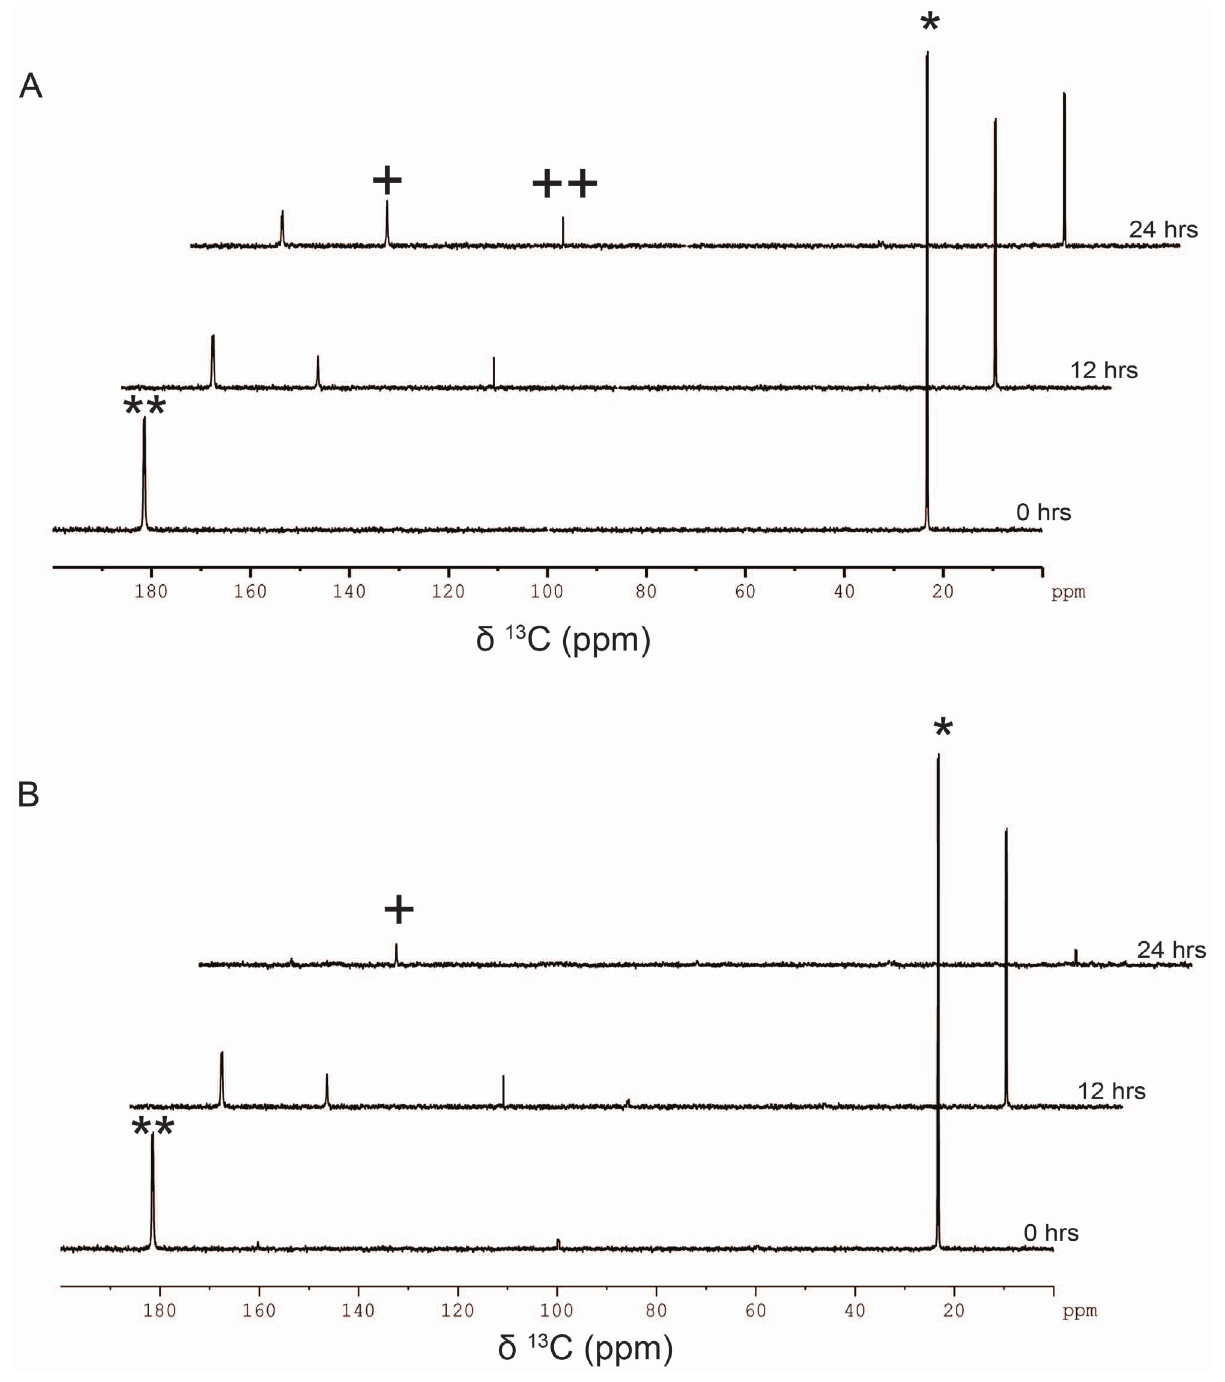
Figure 4. Assimilation kinetics of [1, 2- 13 C]-acetate during heterotrophy and mixotrophy in the presence of photosynthesis inhibitor atrazine. Assimilation kinetics of acetate and metabolite formation by C. reinhardtii during (A) heterotrophy and (B) mixotrophy following the addition of [1, 2- 13 C]-acetate to the TP medium containing atrazine (5 m M). Atrazine stock (10 mM) was prepared in water from where 5 m M atrazine was achieved. (The signs * and ** represent methyl and carboxyl peaks, respectively, of [1, 2- 13 C]-acetic acid, and the signs + and ++ represent bicarbonate and CO 2aq peaks, respectively). doi:10.1371/journal.pone.0106457.g004 (Fig. 1C and 3C). Early production of starch and lipid during starch and lipid accumulation, it takes much longer time. Several photoautotrophy was suggestive of a more efficient flux of carbon days of nutritional stress precedes starch and lipid formation towards the starch and lipid biogenesis via Calvin cycle route. during mixotrophy. We suggest that this delay is perhaps due to Even though acetate assimilation during mixotrophy leads to the conditions of high intracellular Ci and attendant low efficiency